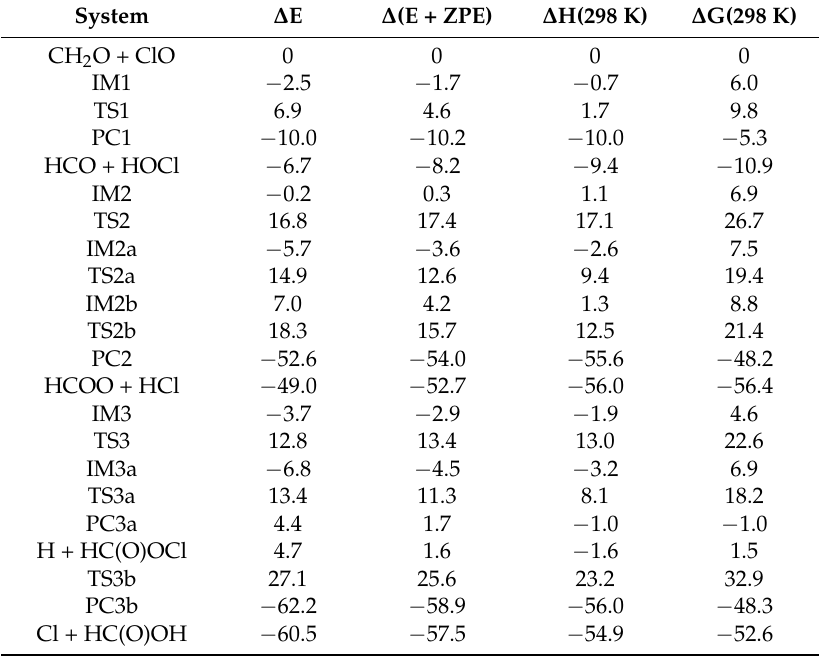
Table 1. Electronic energies ( ∆ E and ∆ (E + ZPE)), enthalpies [ ∆ H(298 K)], and Gibbs free energies [ ∆ G(298 K)] for the CH 2 O + ClO water-free reaction. The units of the energies are kcal mol − 1